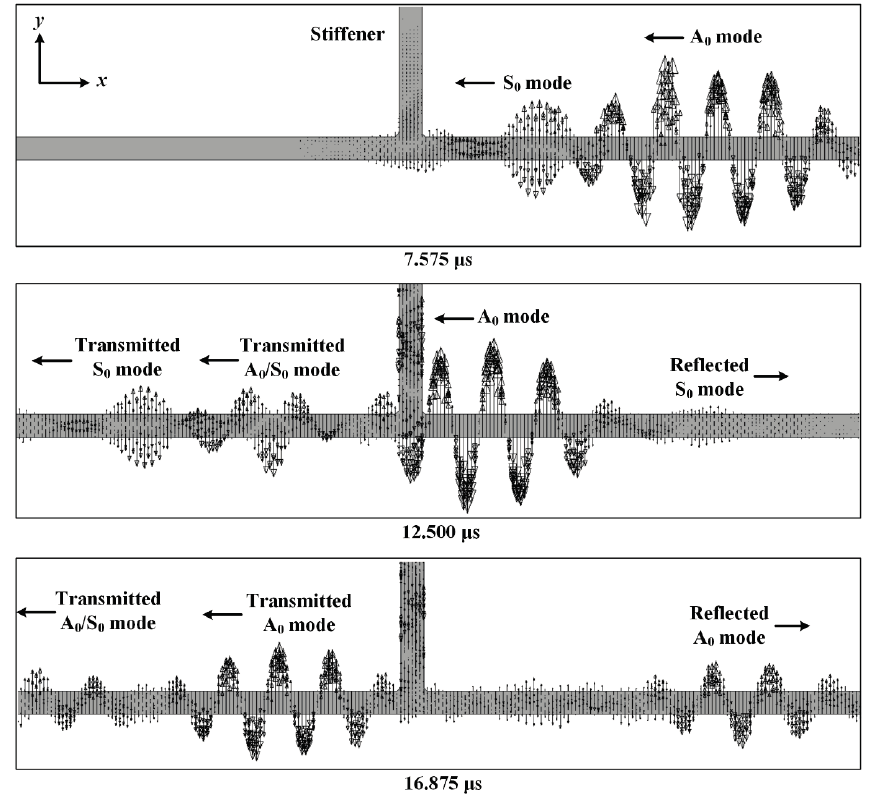
Figure 8. Representative Lamb wave interactions with a vertical